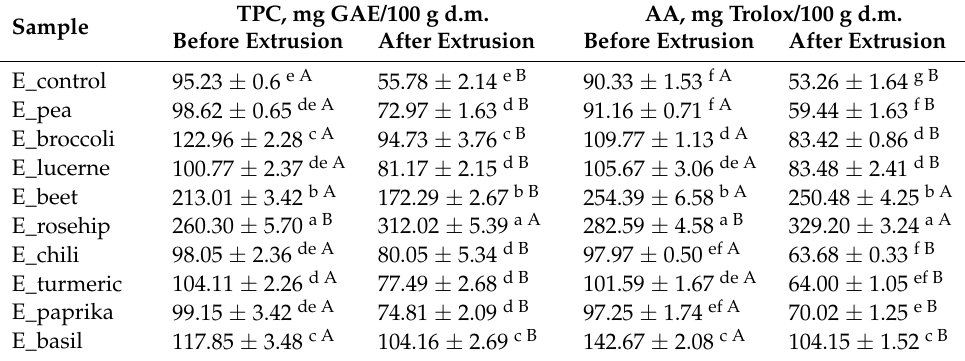
Table 4. Total polyphenolic content (TPC) and antioxidant activity (AA) of raw mixtures (before extrusion) and extrudates (after extrusion). TPC, mg GAE/100 g d.m. AA, mg Trolox/100 g